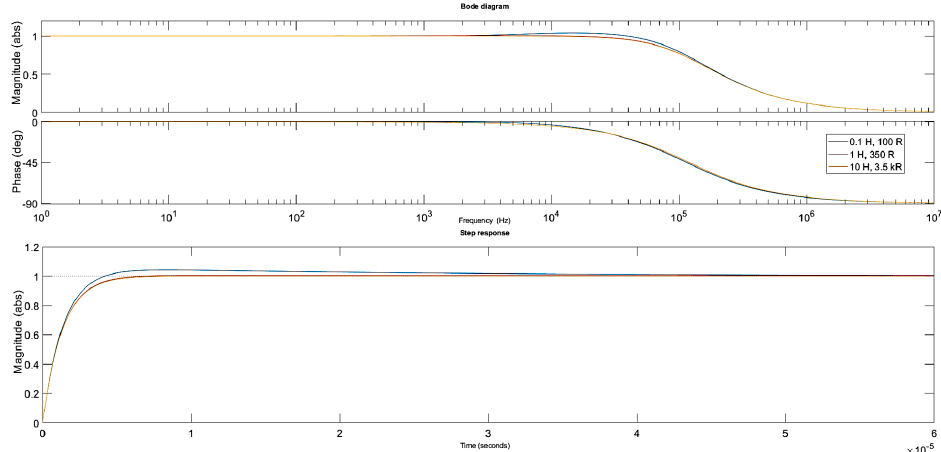
Figure 4. Bode and step response plots for the different inductor parameters. The parallel resistor R 1 and the piezo stack settings remained constant.